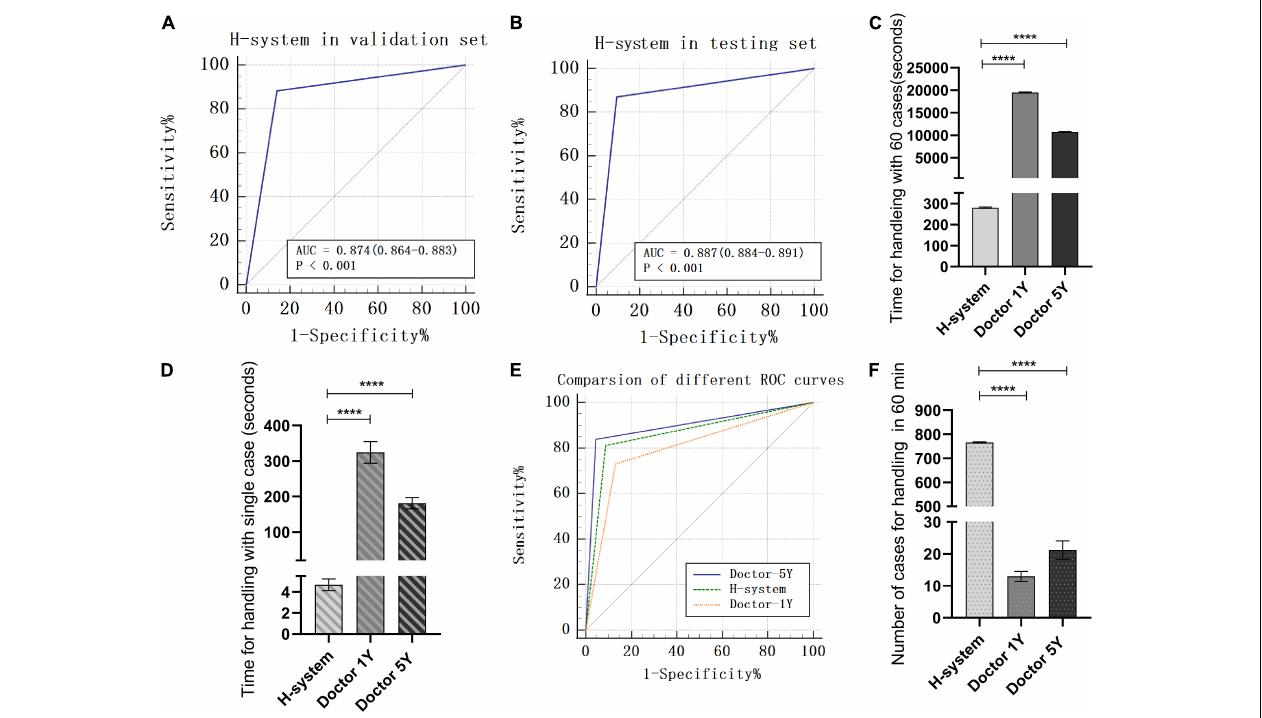
FIGURE 2 | Testing of H-system’s efficiency and reliability. (A) ROC of H-system in validation set. (B) ROC of H-system in testing set. ( A and B meant that the treatment output by H-system was accurate and reliable.) (C) The total time H-system, Doctor-1Y, and Doctor-5Y spent on 60 cases. (D) The mean time